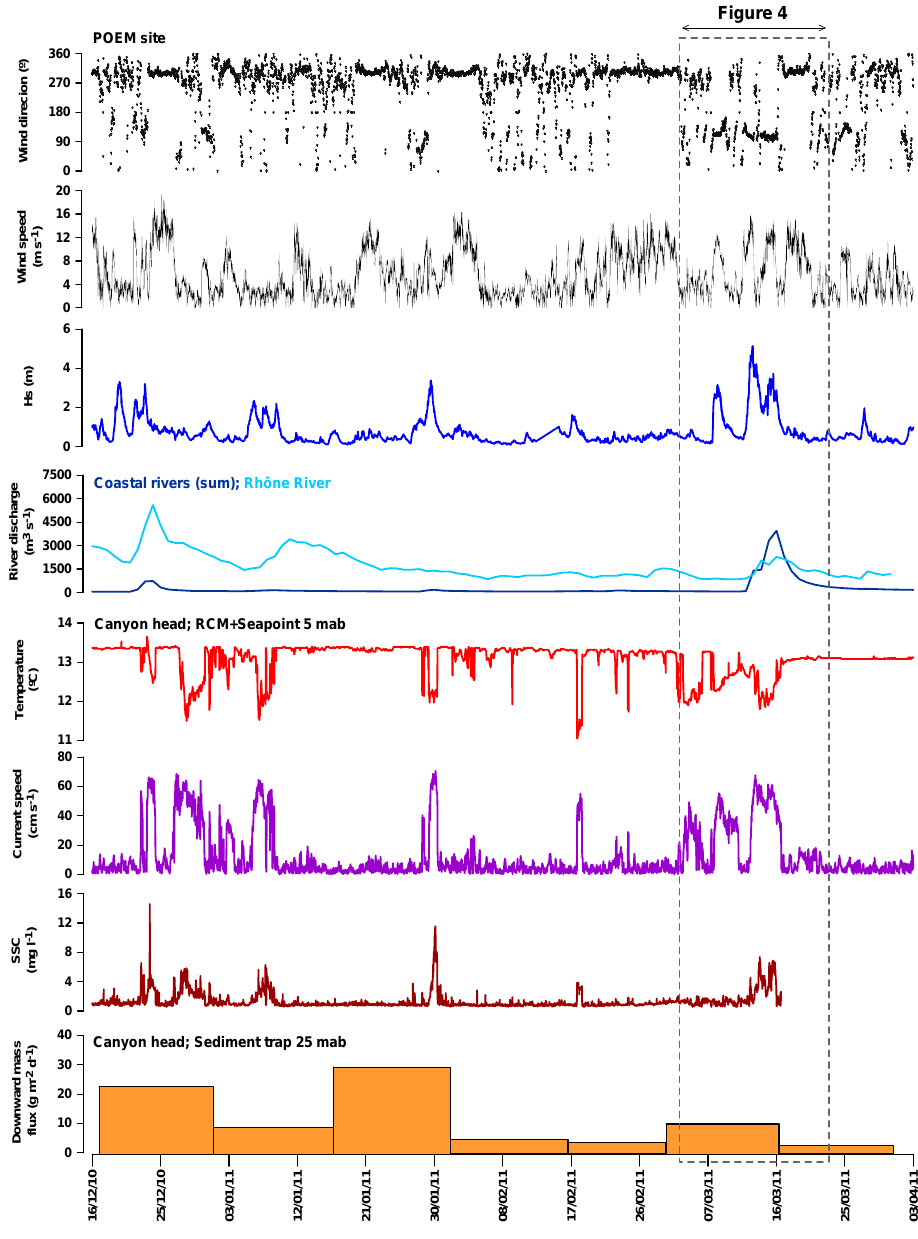
Fig. 3. General meteorological, hydrological and oceanographical setting in the study area, and hydrodynamic and particle flux response at the semi-permanent mooring line installed at the Cap de Creus Canyon head during winter 2010–2011. From top to bottom: wind speed, wind direction and significant wave height recorded at the POEM site (see Fig. 1a for location); mean daily water discharge of the Rhˆone River and the sum of coastal rivers opening to the Gulf of Lion; near-bottom water temperature, current speed, suspended sediment concentration and downward mass flux at the canyon head (300m water depth). The dotted square marks the dates of the CASCADE cruise.